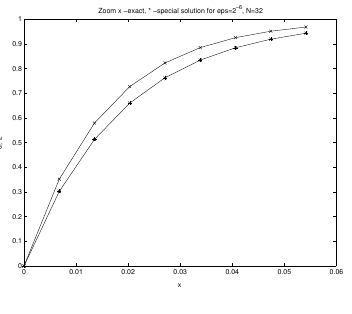
Figure 2. Zoom × - exact solution, ∗ - special solution for ε = 2 − 6 , N =